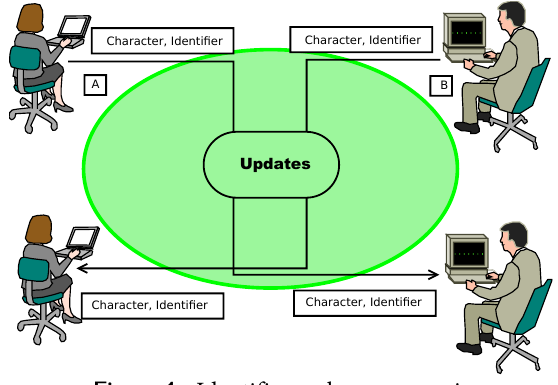
Figure 1. Identifier exchangescenario (Figure 1) in which two users A and B insert character concurrently and interchange